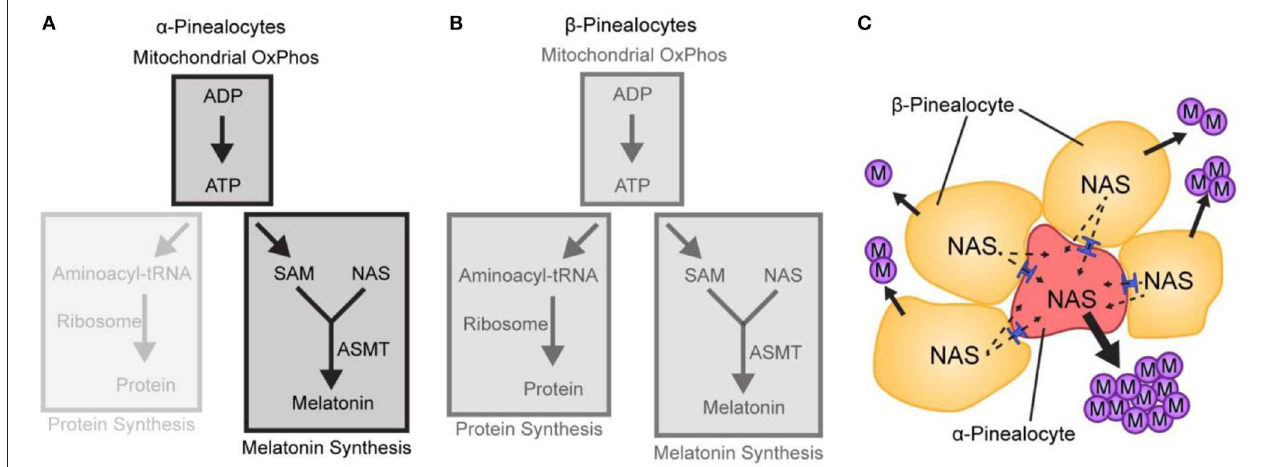
FIGURE 8 | A hypothetical model based on scRNA-Seq depicting differences in melatonin synthesis between α - and β -pinealocytes. (A,B) The relative strength of a pathway module is indicated by opacity; greater opacity represents a more active pathway. (A) Conversion of N-acetylserotonin (NAS) to melatonin in α -pinealocytes is enhanced by higher ASMT activity and increased S-adenosyl methionine (SAM) availability, which is boosted by greater ATP availability. Increased ATP availability reflects increased ATP production from oxidative phosphorylation (OxPhos); this is inferred by greater expression of mitochondrial genes in α -pinealocytes. ATP availability also results from reduced consumption by protein synthesis, as inferred by decreased ribosomal transcriptome in α -pinealocytes. (B) β -Pinealocytes do not have the same enhancements as α -pinealocytes. (C) N-Acetylserotonin (NAS) that is not converted to melatonin in β -pinealocytes enters the α -pinealocyte by passive diffusion through membranes and gap junctions (shown in blue) and is converted to melatonin, thereby maximizing melatonin production. Reproduced from Mays et al. (43). This figure and associated legend is published with permission of the original publisher under license